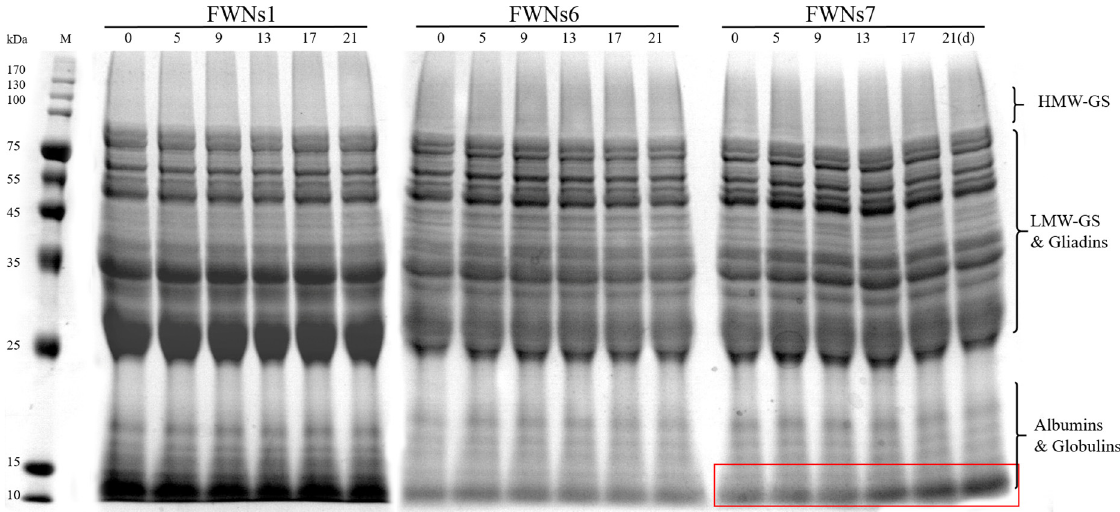
Figure 5. Protein subunits changes of FWNs1, FWNs6 and FWNs7 during storage at 4 ◦ C. The intensity of the bands in the low molecular weight region increased and it was highlighted with a red rectangle.